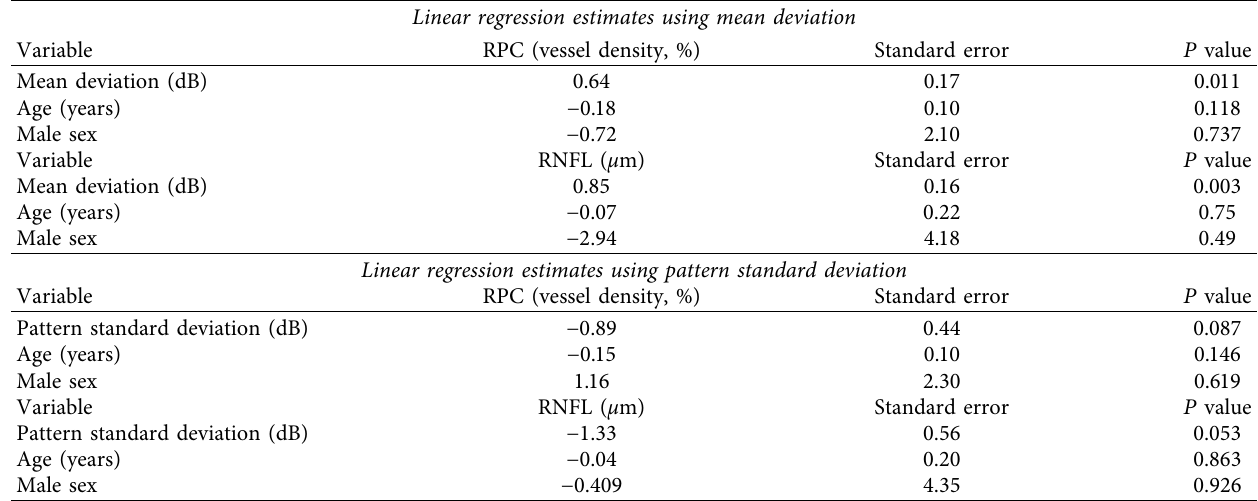
Figure 1: Scatterplots demonstrating linear relationship of structural and functional measures. Structural measures included radial peripapillary capillary (RPC) vessel density (VD) measured by optical coherence tomography angiography and retinal nerve fiber layer thickness (RNFLT) measured with spectral-domain optical coherence tomography. Functional measures from visual field testing include the mean deviation (MD) and pattern standard deviation (PSD). (a–d) Glaucoma subjects and (e–g) glaucoma suspects. Table 2: Linear regression model with robust standard errors of visual and structural parameters adjusted for age and sex in glaucoma